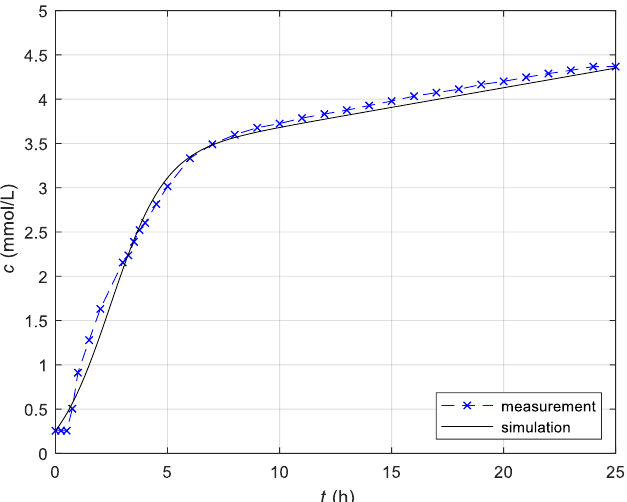
Figure 3. Time courses of the dissolved CO 2 concentration c during the milk fermentation with kefir grains at constant temperature T = 22 °C obtained by measurements and with simulations with the identified Constant temperature model.